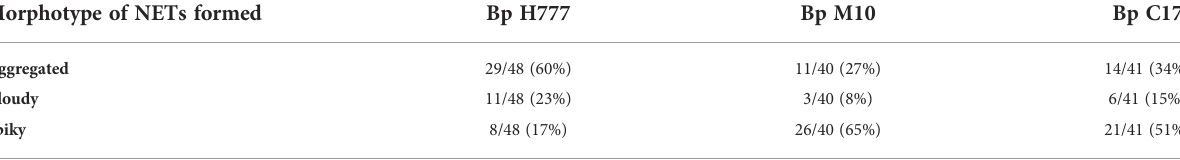
The data are from 3 independent experiments (n ≥